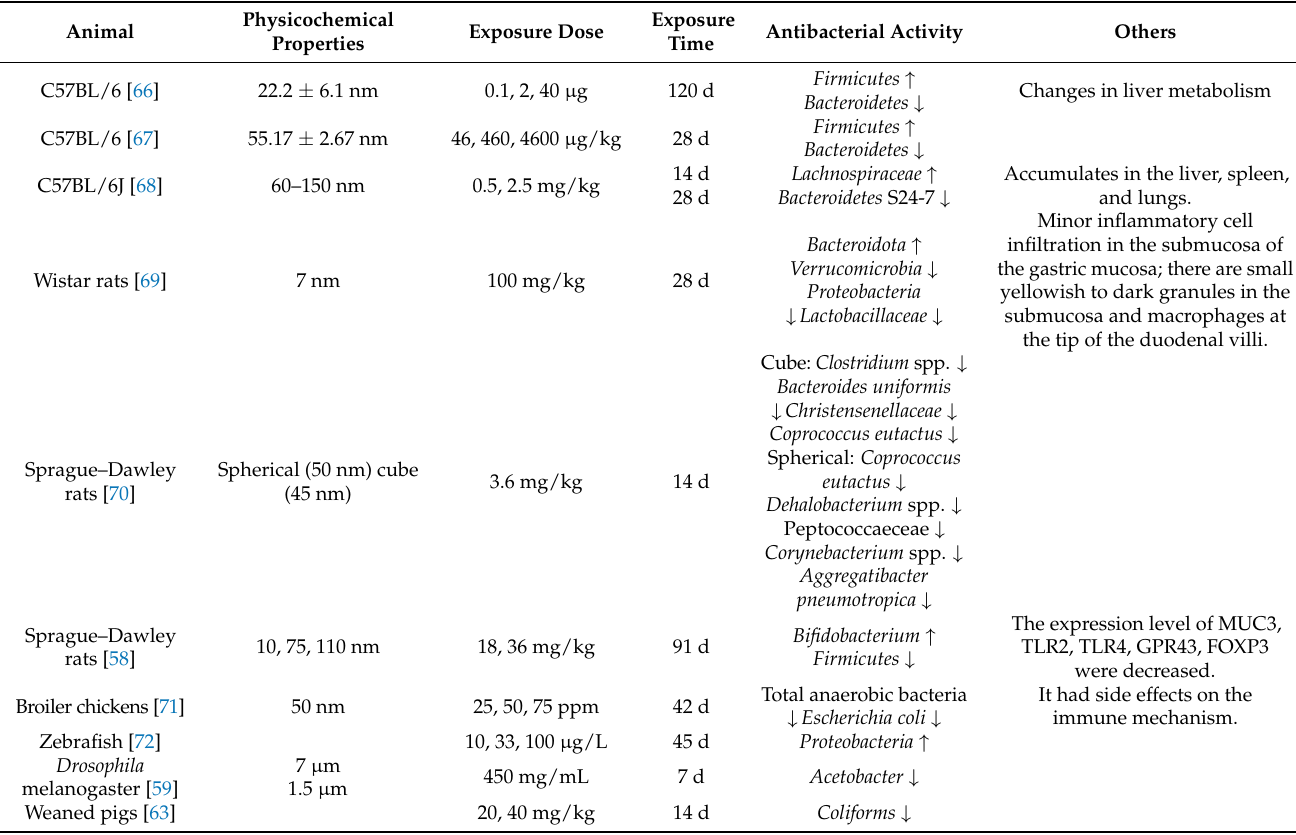
Table 2. Effects of Ag NPs on gut